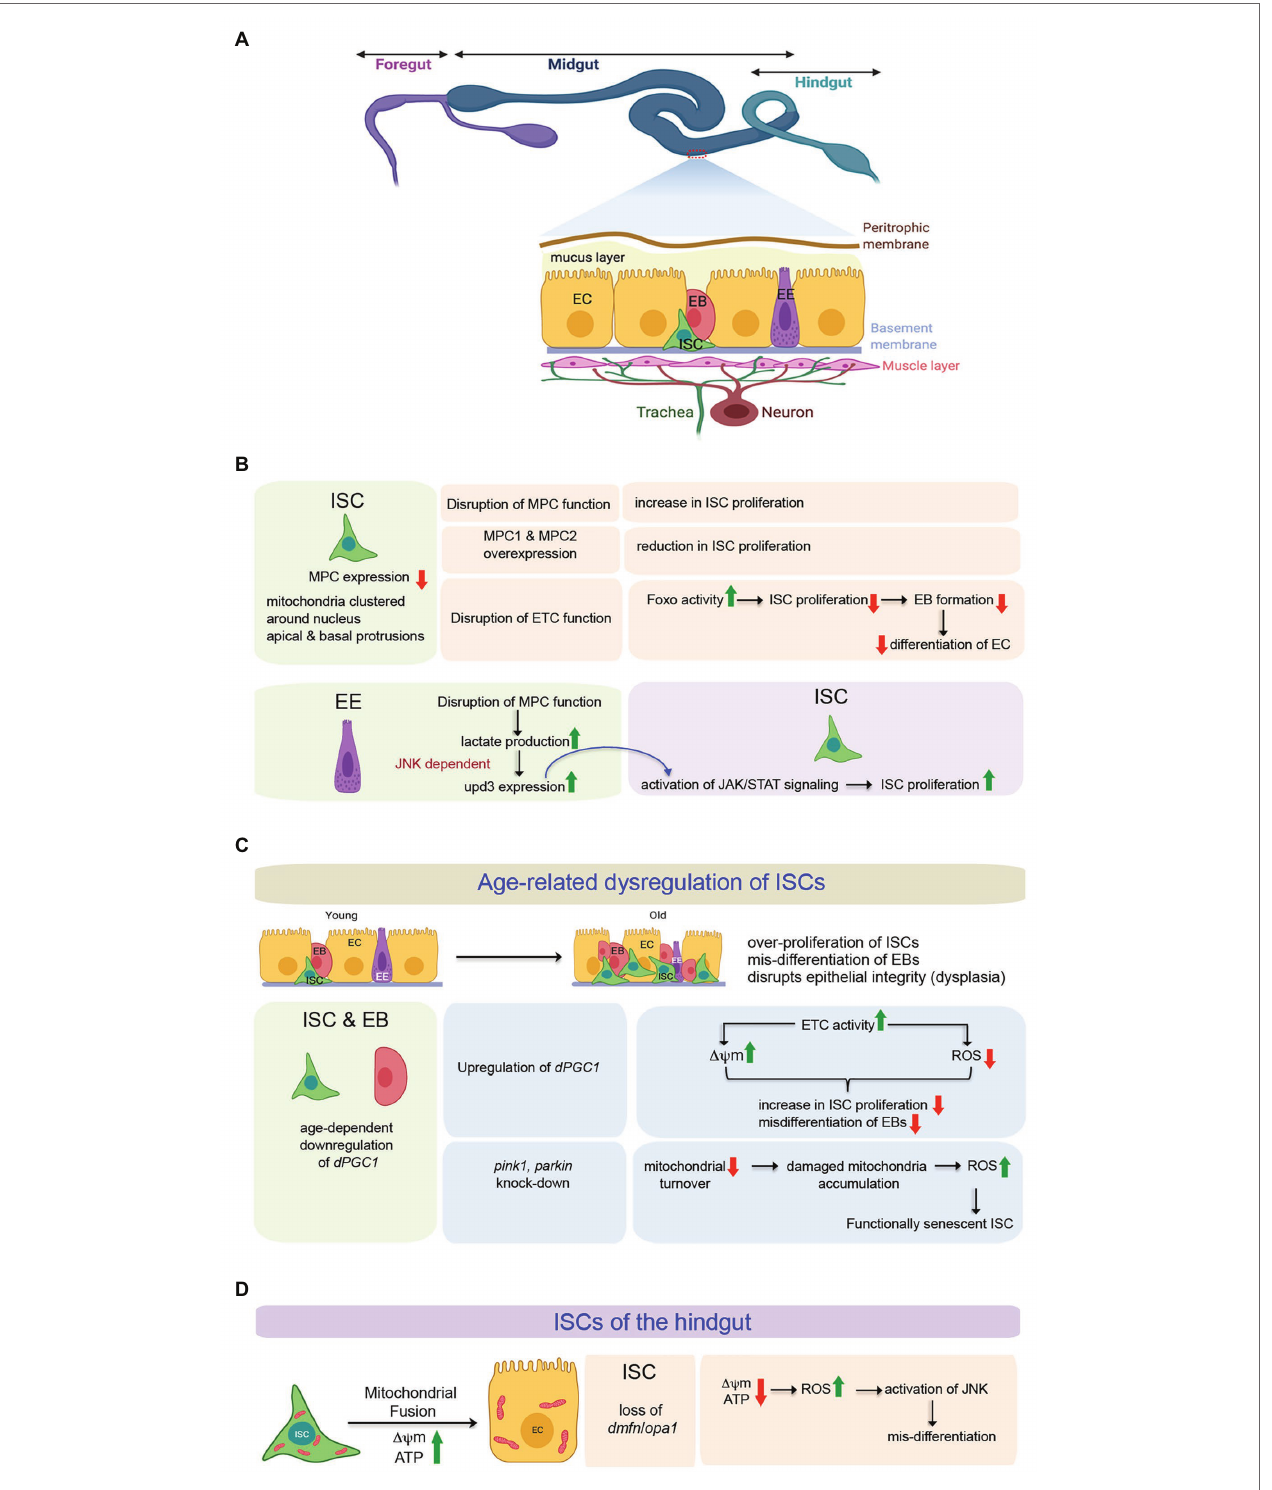
FIGURE 3 | Involvement of mitochondria in defining the state and differentiation of Intestinal Stem Cells (ISCs) in the midgut and the hindgut of Drosophila . (A) Schematic representation of the adult gut of Drosophila highlighting the relative positions of the ISCs and the differentiating cell types in the midgut epithelium. The expanded forms of the acronyms used are provided in the text. (B) Table showing the importance of mitochondrial function to regulate proliferation and differentiation of midgut ISCs both in cell autonomous and non-autonomous manner. (C) Involvement of mitochondrial processes (biogenesis and turnover) during age-related dysregulation of ISCs in the midgut. (D) Mitochondrial fusion and its importance in the differentiation of hindgut